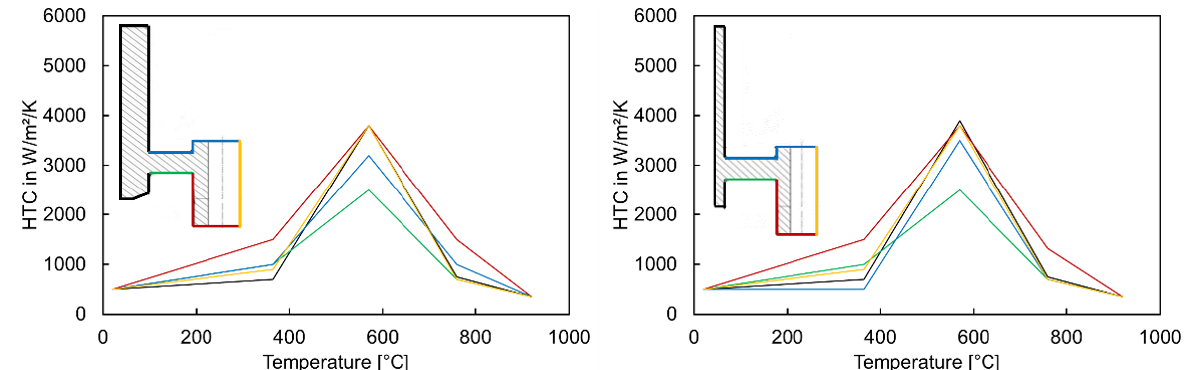
Figure 7. Adjusted HTC for geometry types G3 ( left ) and G5 ( right ).